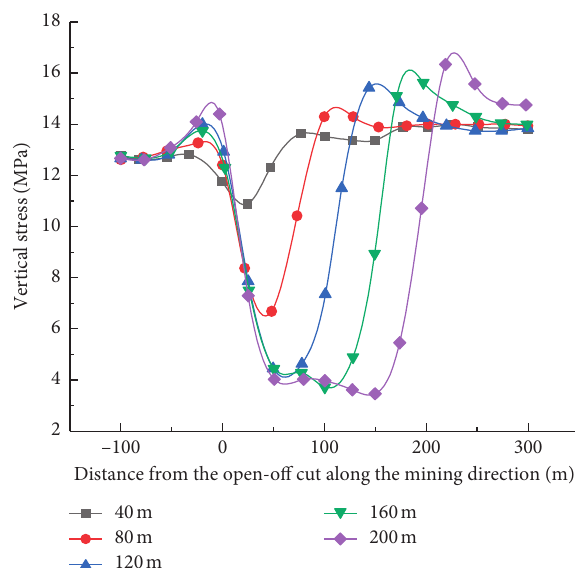
Figure 5: Vertical stress curve for the No. 2-1 coal seam in the mining of the rock-coal composite protective